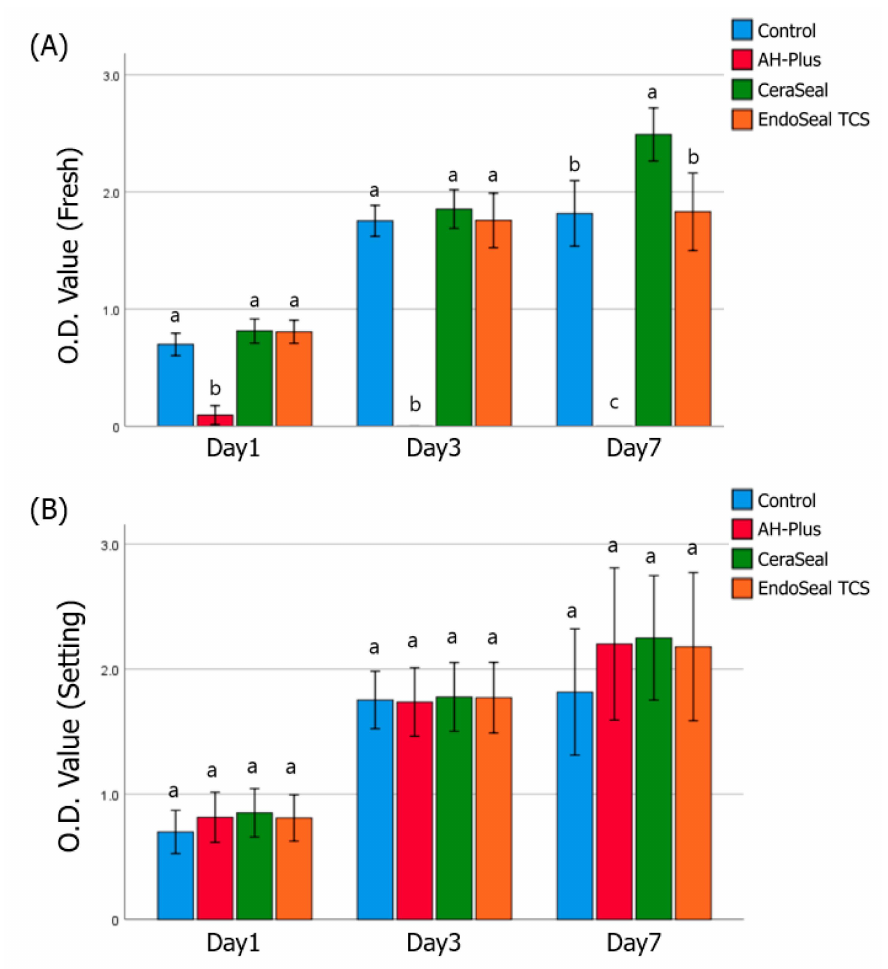
Figure 2. Cell viability of human periodontal ligament stem cells (hPDLSCs). ( A ) fresh sealers, ( B ) set sealers. Di ff erent alphabets indicate that there is a di ff erence between the materials within the same time group ( p <